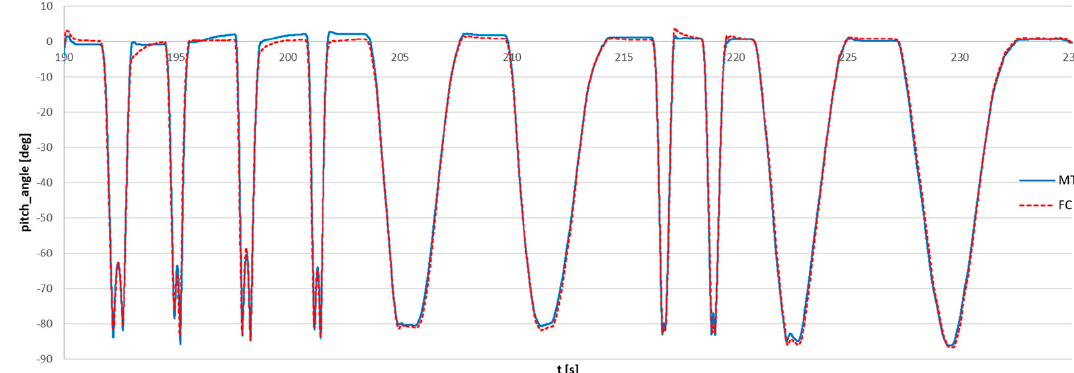
Figure 16. Comparison of dynamic angle measurement using the flight controller sensor (FC) and reference Xsens MTi G-700 sensor (MTi).